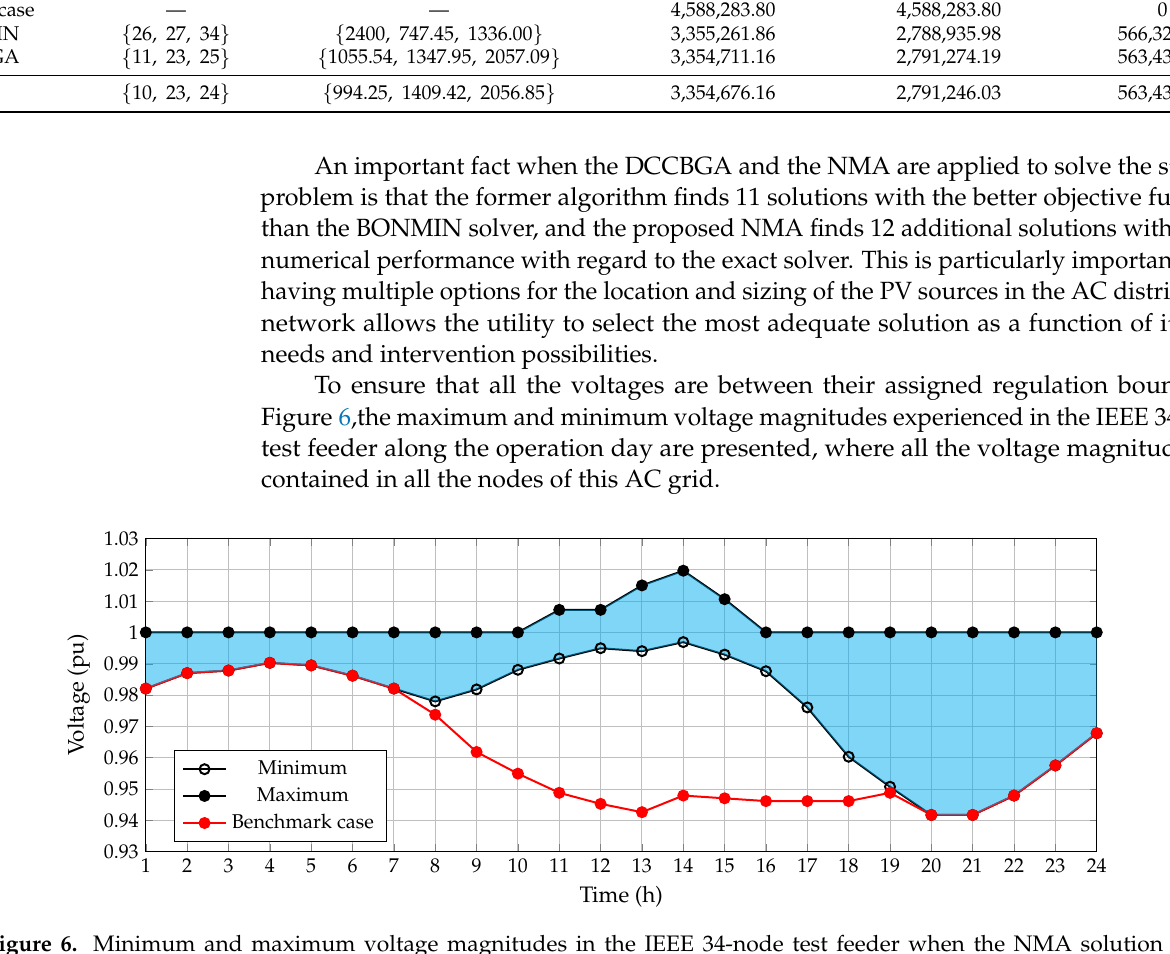
Figure 6. Minimum and maximum voltage magnitudes in the IEEE 34-node test feeder when the NMA solution is